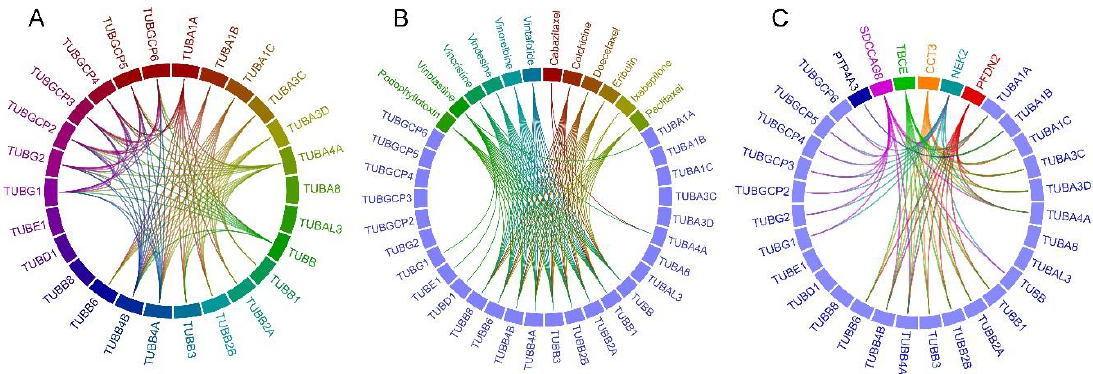
Figure 1. Circle plot of protein-protein and drug-protein interaction in BC tumors. ( A ) Interaction of tubulin isoforms with each other. ( B ) Interaction of FDA-approved drugs with target tubulin isoforms. ( C ) Interaction of frequently altered (minimum of 20% of cases) neighbor genes in tubulin pathways with tubulin isoforms in meta-study BC samples.